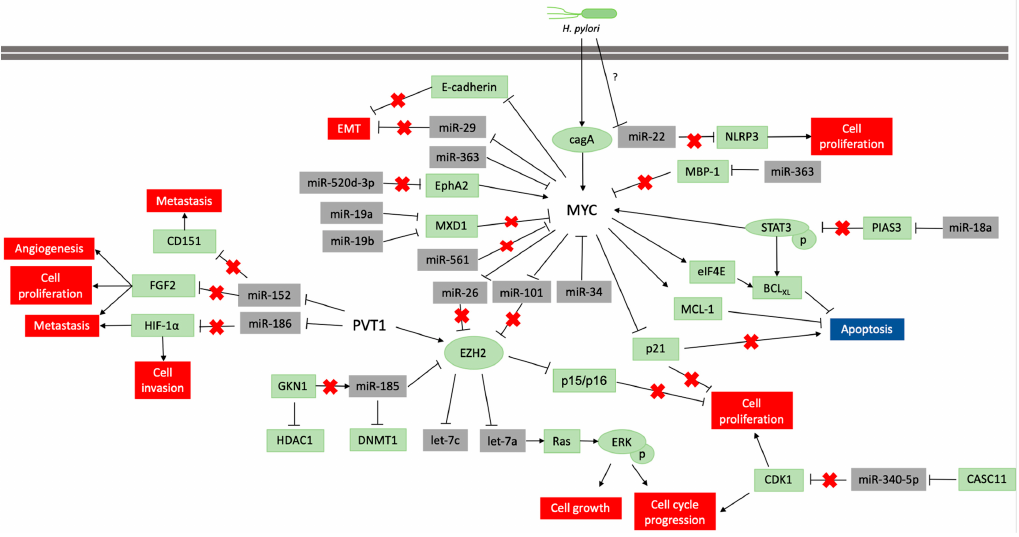
Figure 3. Pathways scheme in which miRNAs regulate MYC and PVT1 expression and vice versa in neoplastic gastric tissue samples and cell lines. The coding genes are shown in green, and the non-coding genes in grey. Lines ending with an arrow indicate activation, whereas T ending lines indicate repression. Lines with a red cross indicate that the interaction is lost due to repression or blocking of a miRNA or protein.